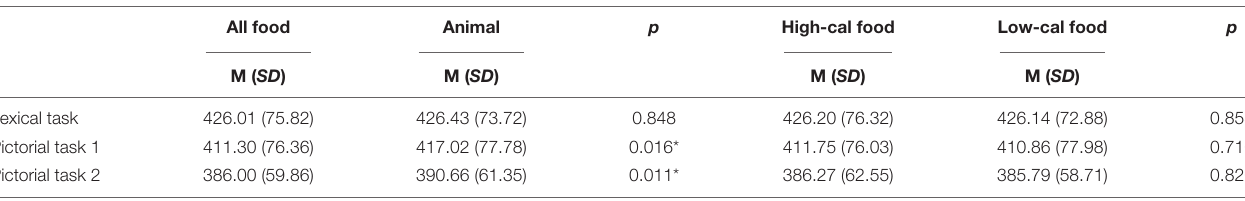
TABLE 2 | Mean reaction time for all tasks, by stimulus category. All food